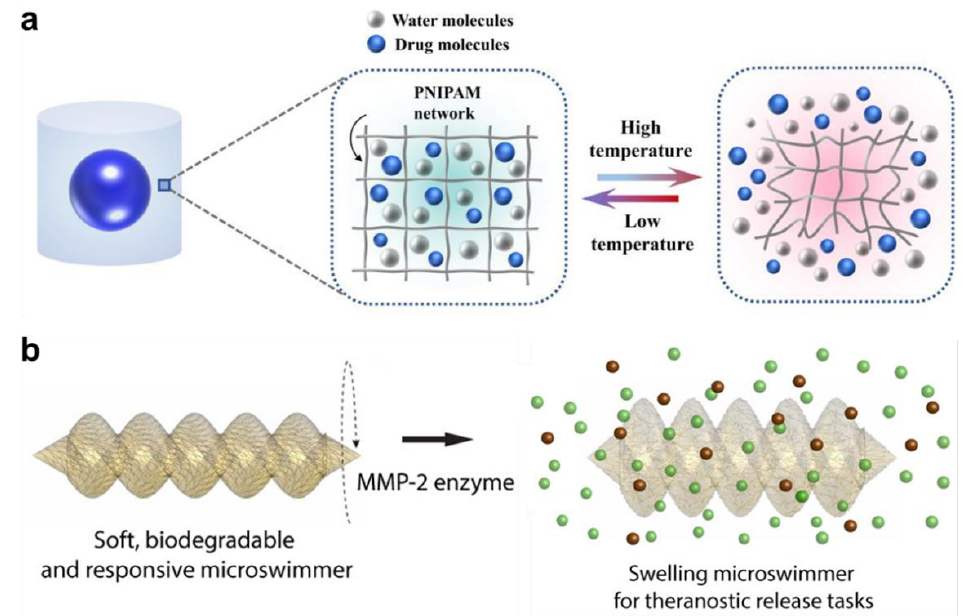
Figure 10. ( a ) Schematic of 4D printed core–shell (Brilliant blue—PNIPAM) capsule and their temperature responsive drug release. Reproduced with permission from [150]. Copyright © 2022 Elsevier. ( b ) Schematic of 4D printed Gelatin methacryloyl microbotic swimmers and their enzyme (Metalloproteinase 2) responsive drug (Fluorescein isothiocyanate–dextran) release. Reproduced with permission from [153]. Copyright © 2019. American Chemical Society.